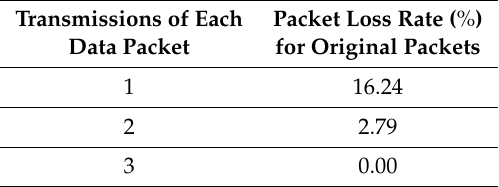
Table 1. PLR (%) in data transmission between a single broadcaster and a single CSR observer device, according to the number of packet